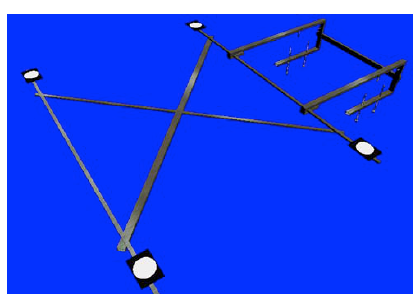
Figure 4. Auxiliary crosshead to assist planar projective